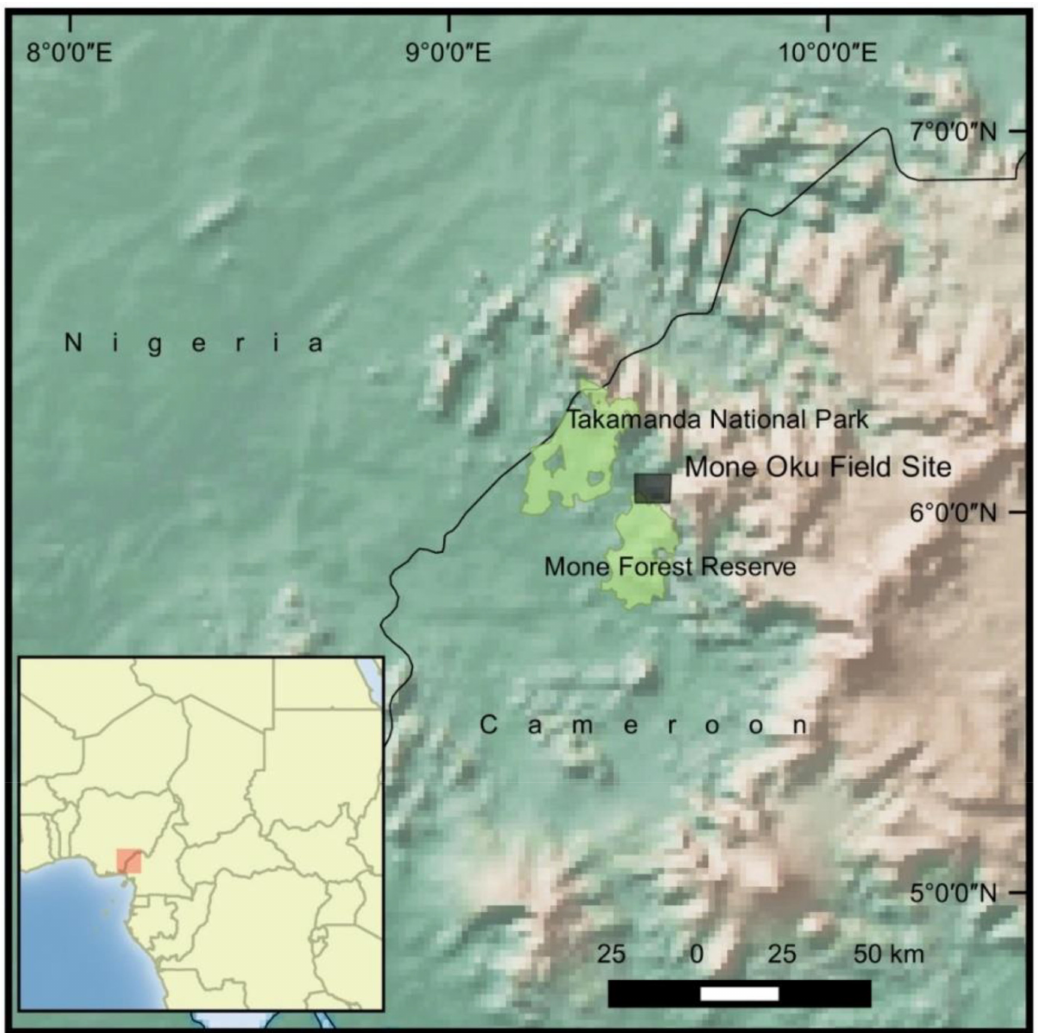
Figure 1. Location of the Mone-Oku study area, Southwest Cameroon. Insert: location of the region within Central- West